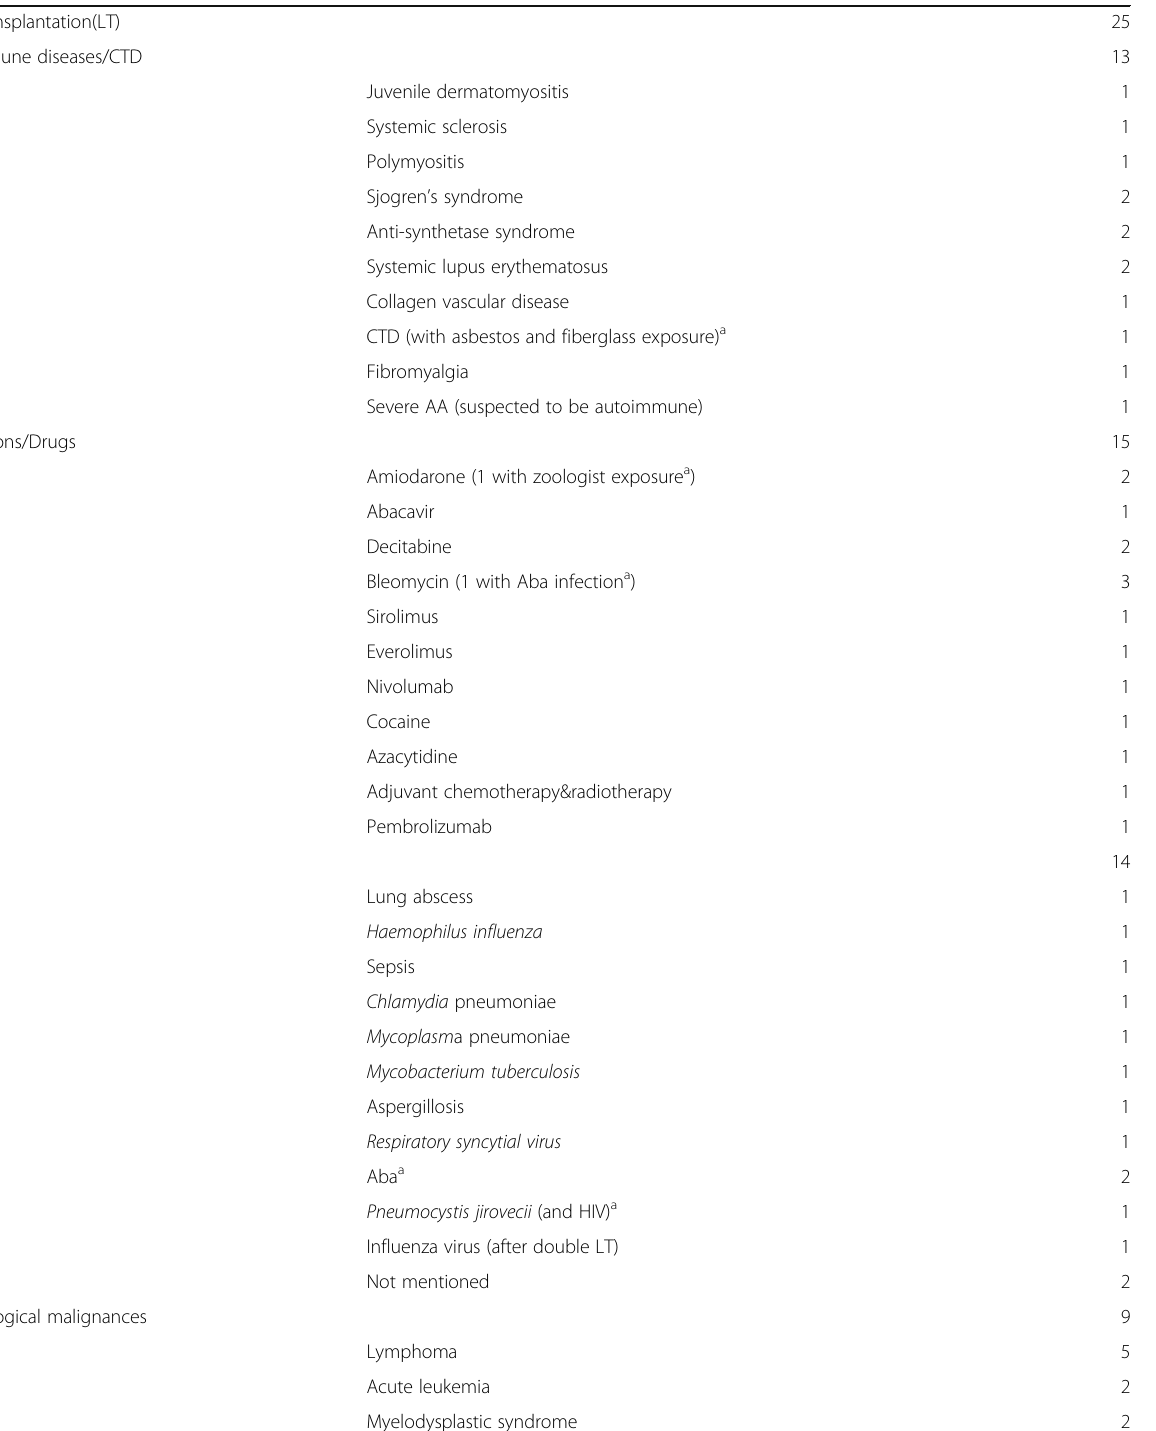
Table.2 Possible causes or associations with AFOP Associations Lung